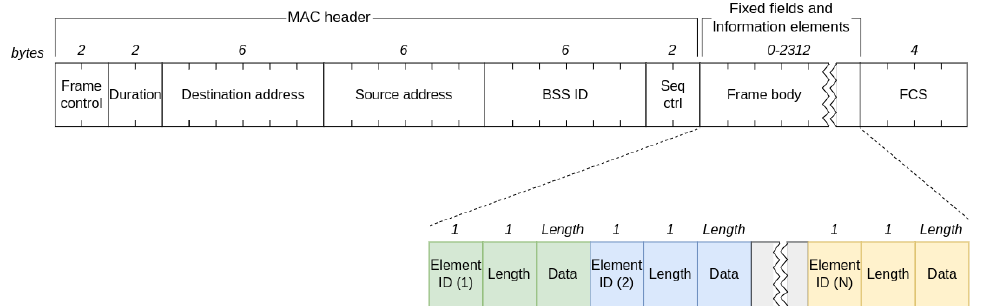
Figure 1. Generic 802.11 management frame with IE fields in the frame